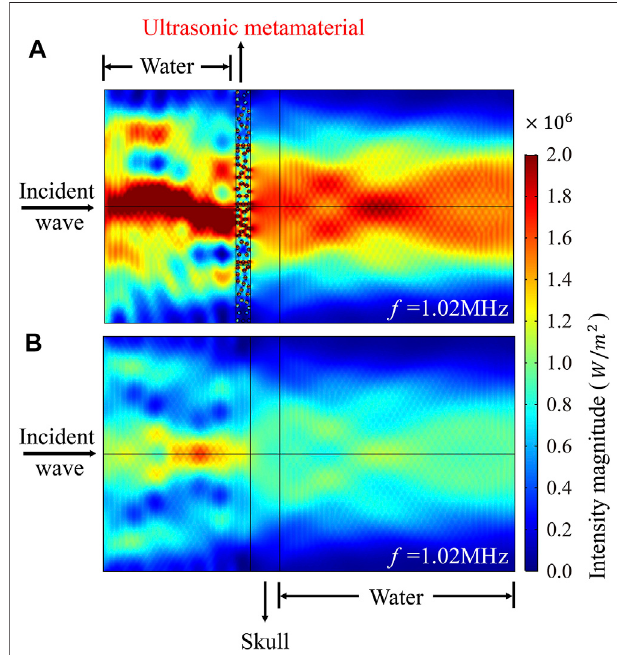
FIGURE 4 | Ultrasound intensity distribution under two conditions. (A) Ultrasonic metamaterial is placed in front of the skull layer. (B) Only skull layer without the ultrasonic